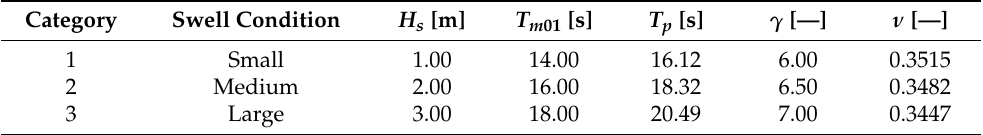
Table 2. Selected sea state